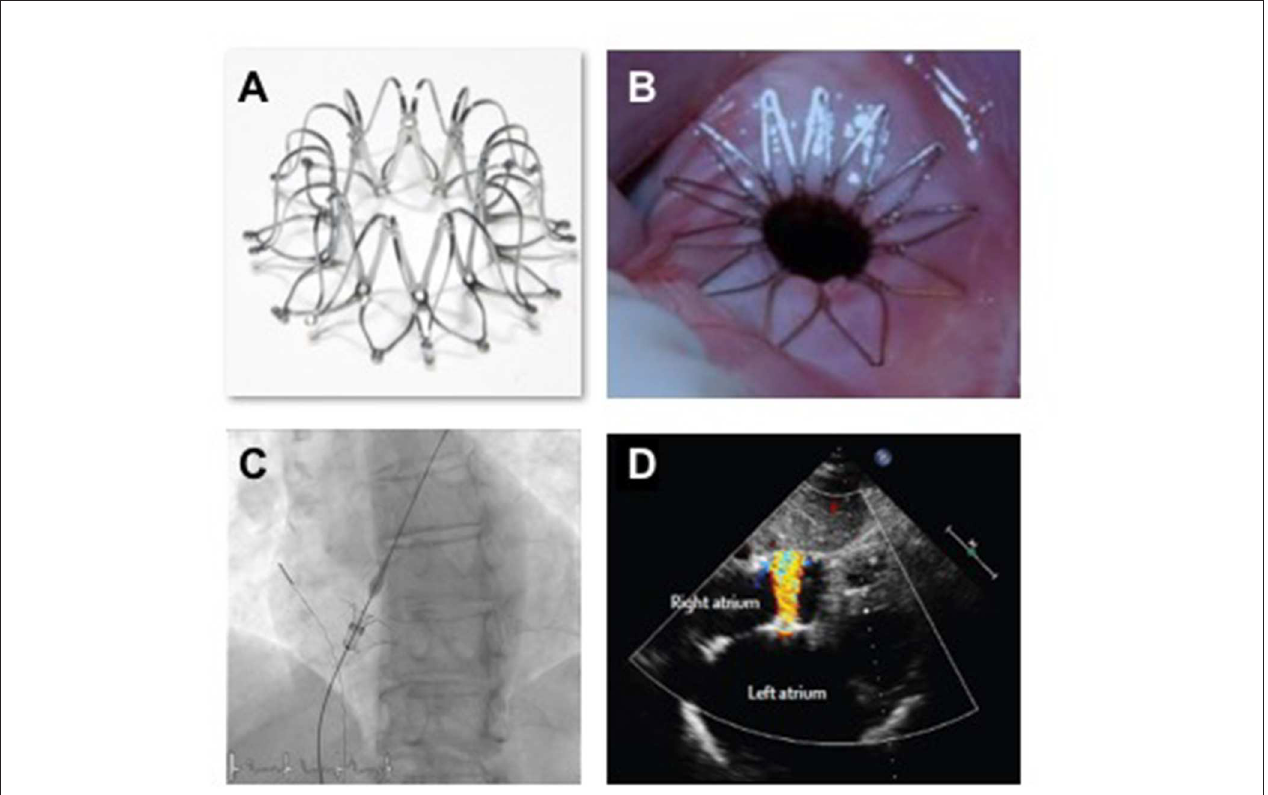
FIGURE 4 | Images (A,B) show the IASD; (C) show the fluoroscopic image of IASD delivery; (D) echocardiographic image showing left to right blood